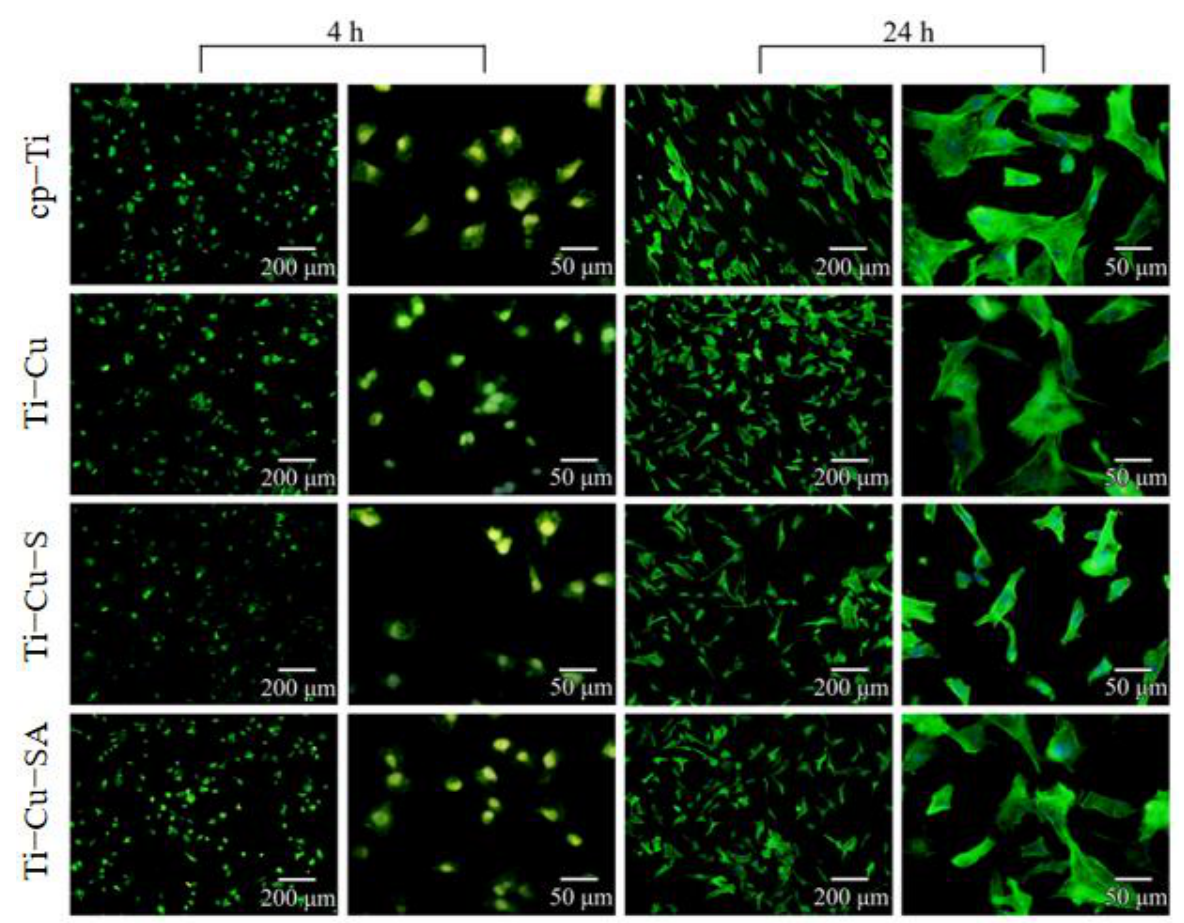
Figure 8. Cytoskeleton staining of MC3T3-E1 on the samples at different time intervals.